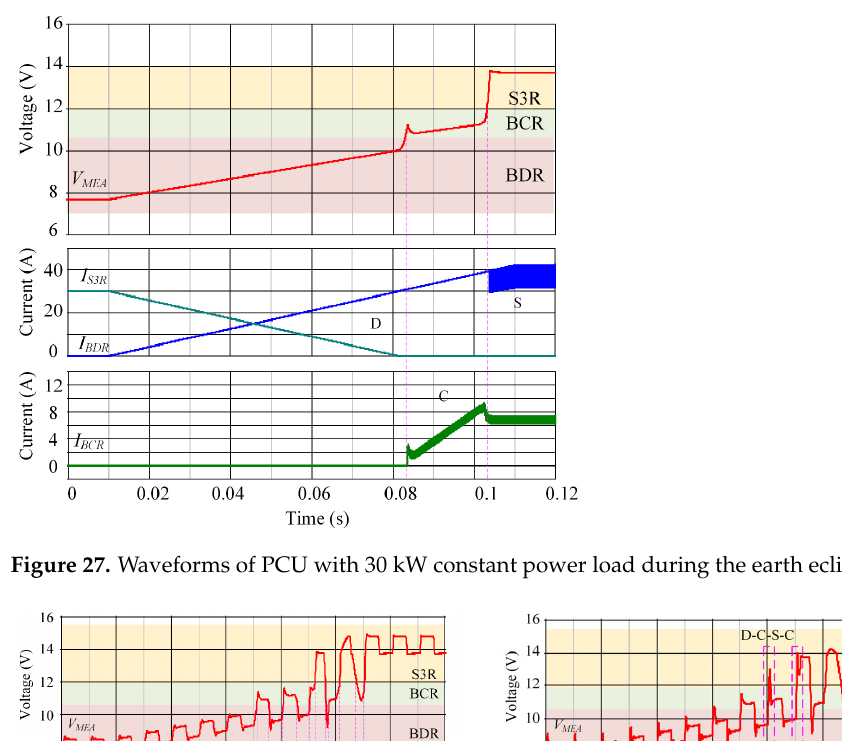
( d ) Figure 26. Influence of arc on SR operation mode. ( a ) Switch between two operation modes when stable arc occurs in SR ‐ 2 (switching mode); ( b ) Switch between two operation modes when intermittent arc occurs in SR ‐ 2 (bus feeding mode); ( c ) Switch between two operation modes when stable arc occurs in SR ‐ 2 (bus feeding mode); ( d ) Switch among three operation modes when arc occur at random in two SRs. 6.3. Simulation of Non ‐ Linear Phenomena of Solar Array and Load during the Earth Eclipse A PCU system model with a V bus of 100 V was built to simulate the non - linear behavior of the payload during the Earth eclipse period. The present study used four ‐ section SRs in the equivalent simulation, and the output current of each sec ‐ tion of the solar array was 10.5 A. The process of the satellite leaving the penum ‐ bra period was simulated within 100 ms, and the recovery of the output current of the solar array during the process was equivalent to a linear increase. The waveforms of the PCU with 20–30 kW pulsed load during the eclipse period